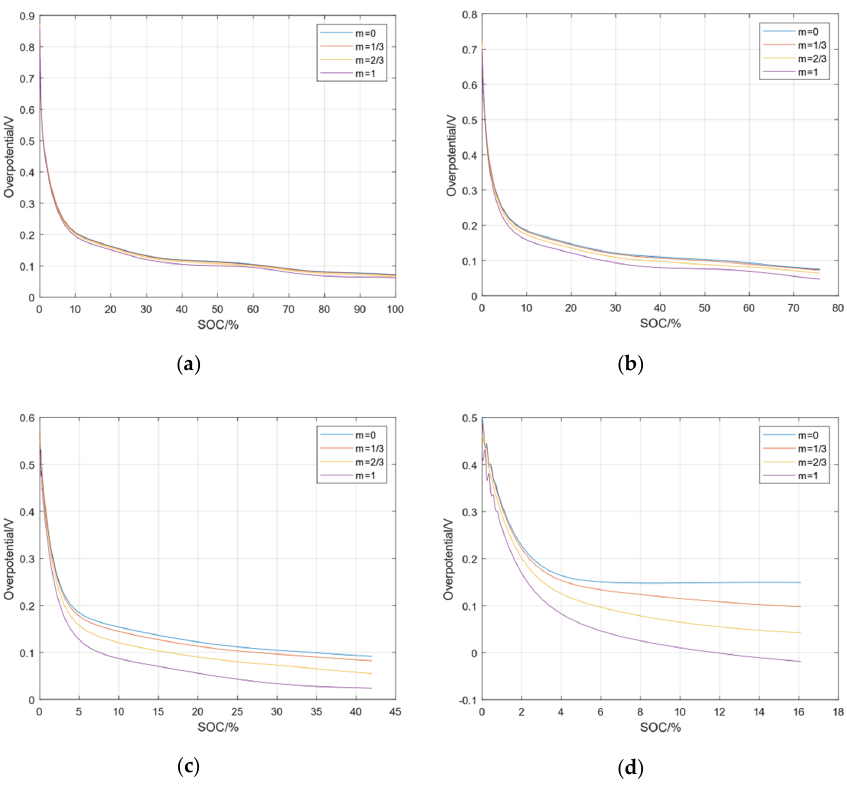
Figure 6. The heterogeneous side reaction overpotentials in the negative electrode. ( a ) Overpotential at 0.5C; ( b ) Overpotential at 1C; ( c ) Overpotential at 2C; ( d ) Overpotential at 3C.